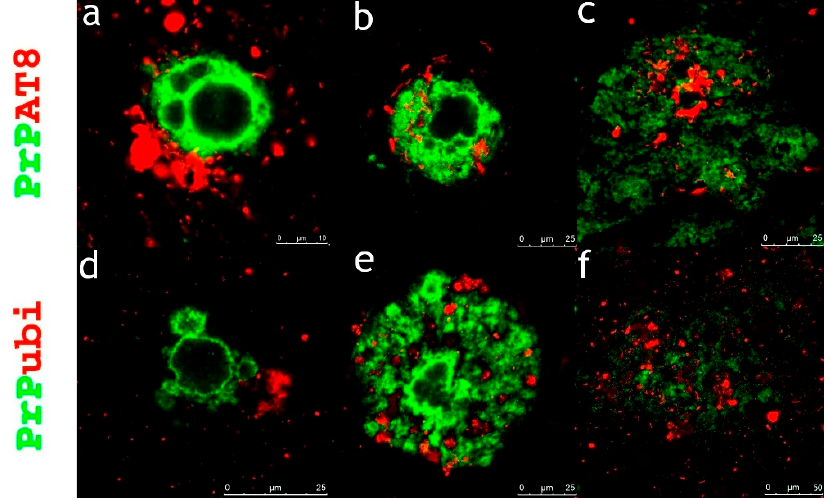
Figure 4. Few observations found condensed PrP with co-aggregates in GSS subjects. Across the cohort, few PrP aggregates either in plaques, kuru-like plaques, or diffuse exhibited a certain level of the hyperphosphorylated protein tau and ubiquitin co-pathology. Primary antibodies: PrP (rabbit recombinant monoclonal antibody, green color), AT8 (mouse monoclonal antibody, red color), ubiquitin (mouse monoclonal antibody, red color). The secondary antibody was conjugated with either Alexa Fluor ® 488 (anti-rabbit IgG, green) or Alexa Fluor ® 568 (anti-mouse IgG, red). Scale bars indicate 10 µ m in ( a ), 25 µ m in ( b – e ), and 50 µ m in ( f